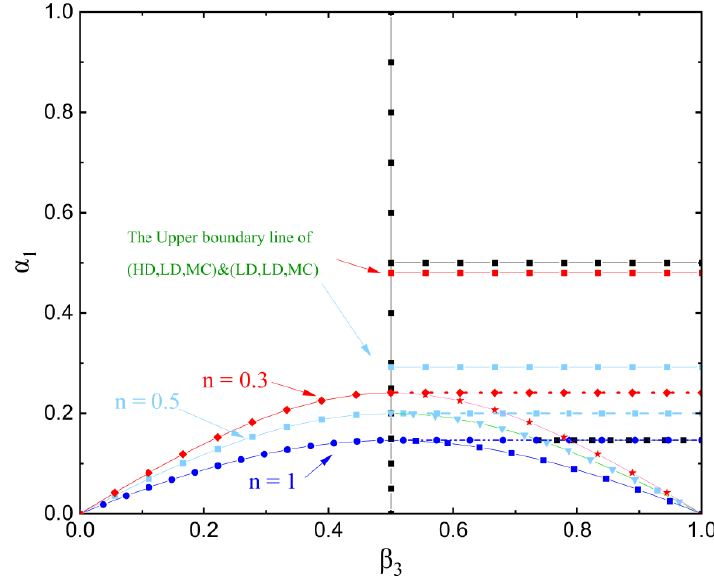
Figure 11. System phase diagram with variable n. Figure 12 presents the particle density distribution of six stationary phase running under specific parameters. The coordinate-axis X is the sequential site in the queue 1/2/3. Points and lines correspond to the results of simulation and analysis respectively. The simulation results are in good agreement with the analytical results. For the LD phase in the system, the density distribution is flat except near the queue boundary. Due to the adaptive adjustment of the YELLOW algorithm, the density distribution of queue 3 can converge to a fixed value around 0.5 regardless of the existence of shock at the queue boundary. Because the yellow algorithm reduces the packet loss rate of queue 1 in order to ensure the forwarding bandwidth, even if both queue 2 and queue 1 are in the LD phase at the same time, the particle density of queue 1 is significantly higher than that of queue 2. The shock appears at the head and tail of queue 3 at the same time, which is caused by the oscillation of the YELLOW algorithm in the time domain. Due to the coexistence phase existing in YELLOW modeling by TASEP, it is difficult to analyze the particle density distribution on each phase boundary by traditional domain-wall theory [50]. Therefore, we will not carry out the experimental analysis here, and will continue to study in the future.